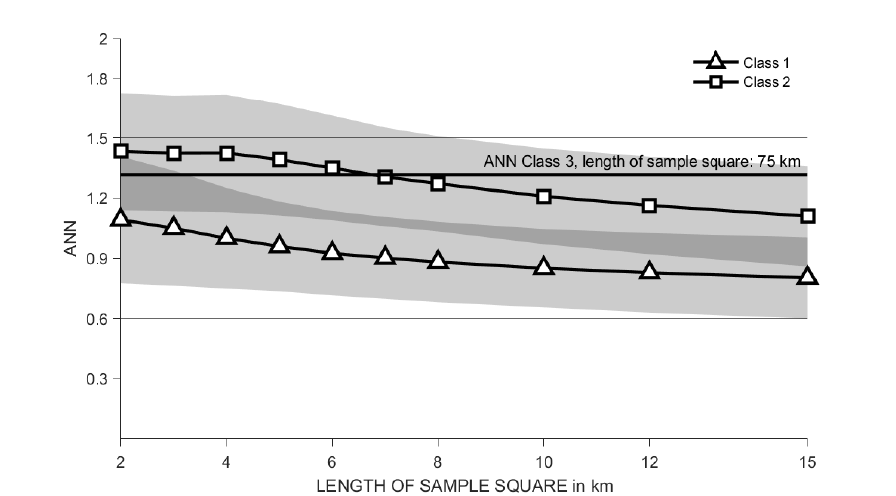
Figure 9. Average ANN in sample squares of different length for Class 1 and Class 2 in the data set